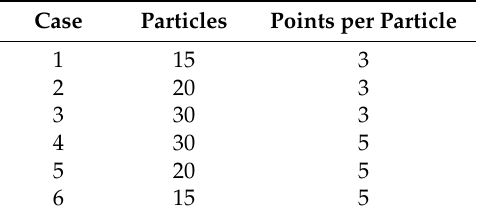
Table 5. Populations considered for the execution in the MOPSO algorithm.